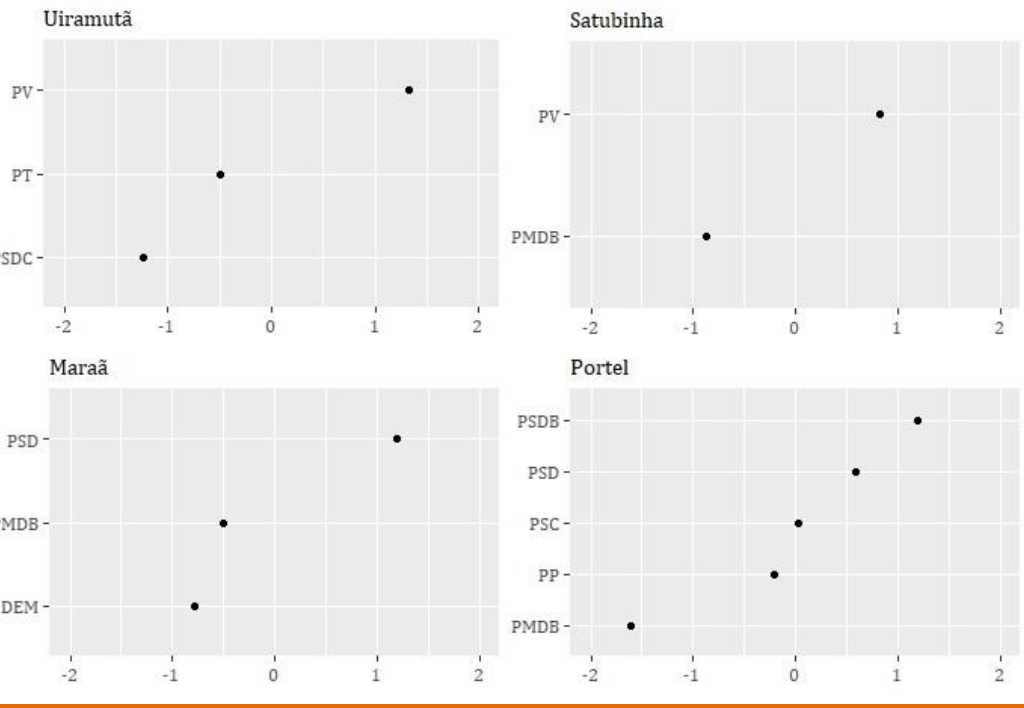
Figure 01. Position of candidates per municipality